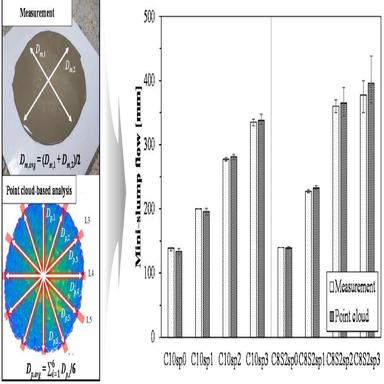
Comparison of mini-slump flow obtained from the measurements and point cloud-based analysis.